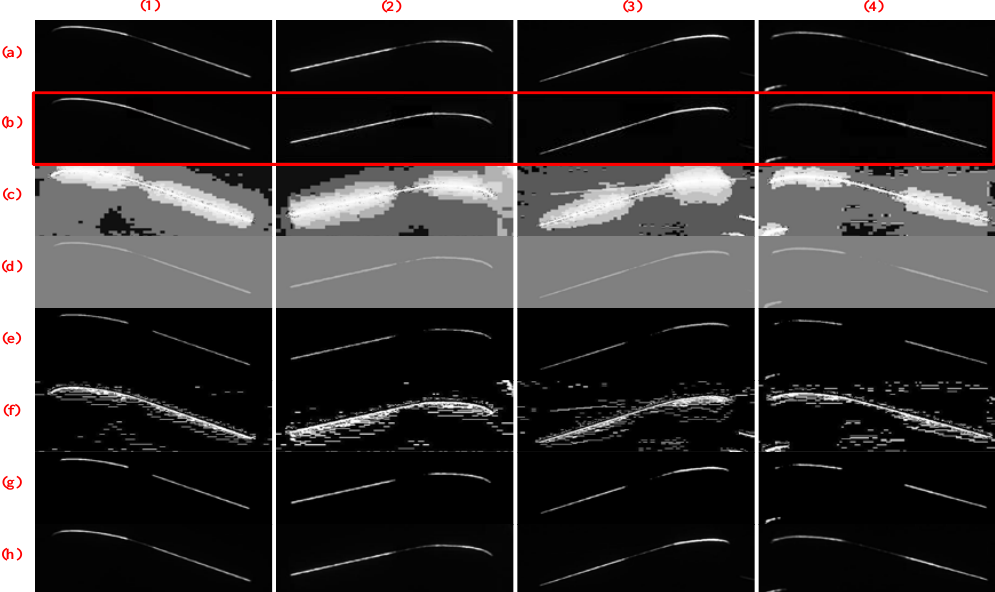
Figure 14. Enhanced results of inner stripe images based on different methods. Columns ( 1 )–( 4 ) present the tread segments with different missing percentages. Row ( a ) displays the raw images. Rows ( b – h ) exhibit the results processed by HE, CA, LT, CF, MF, and SO methods, respectively, and row ( b ) shows the results generated through the proposed method.